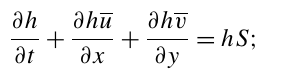
Pink Beach wetland is obtained under different runoff condi- tions.